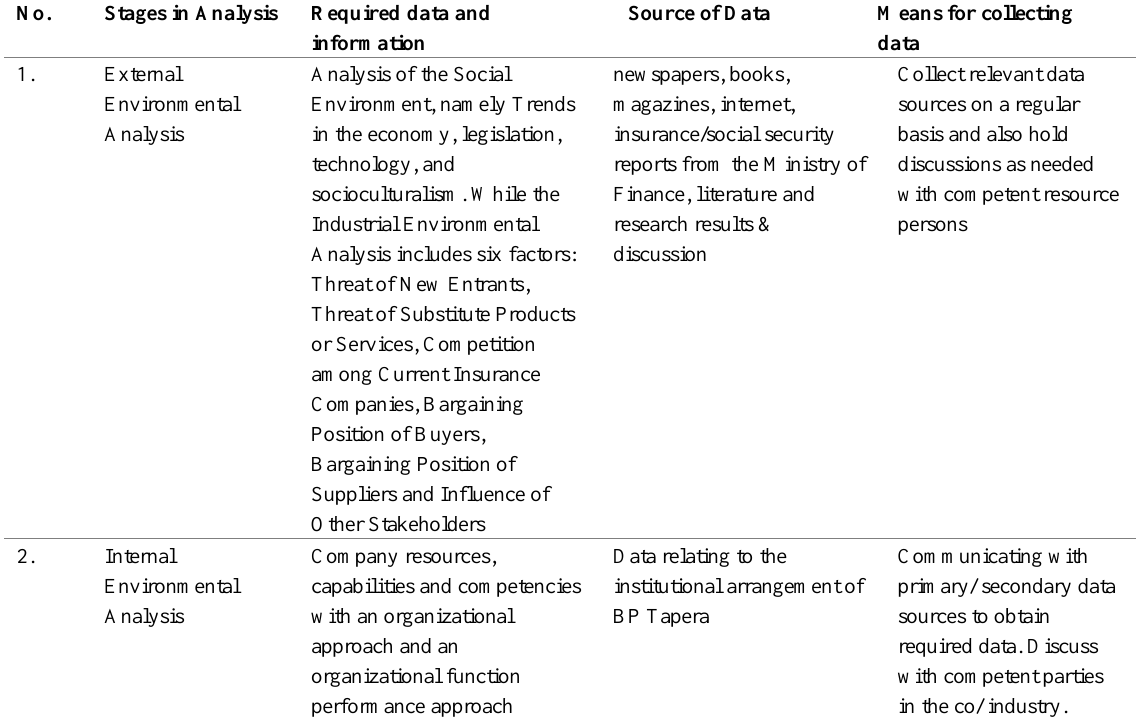
Table 2: Method of Collecting